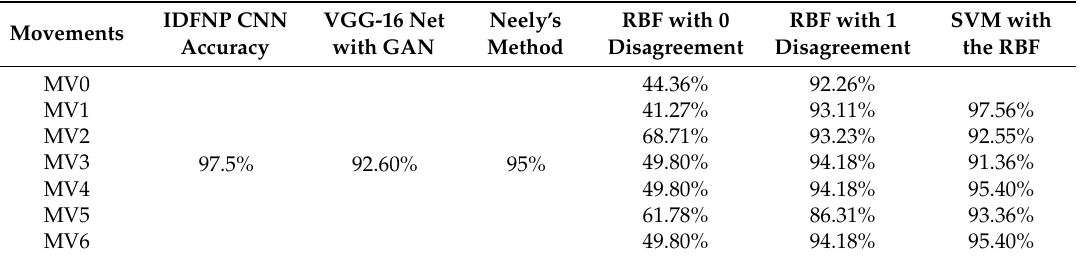
Table 8. Comparison with the other computer-aided analysis systems.